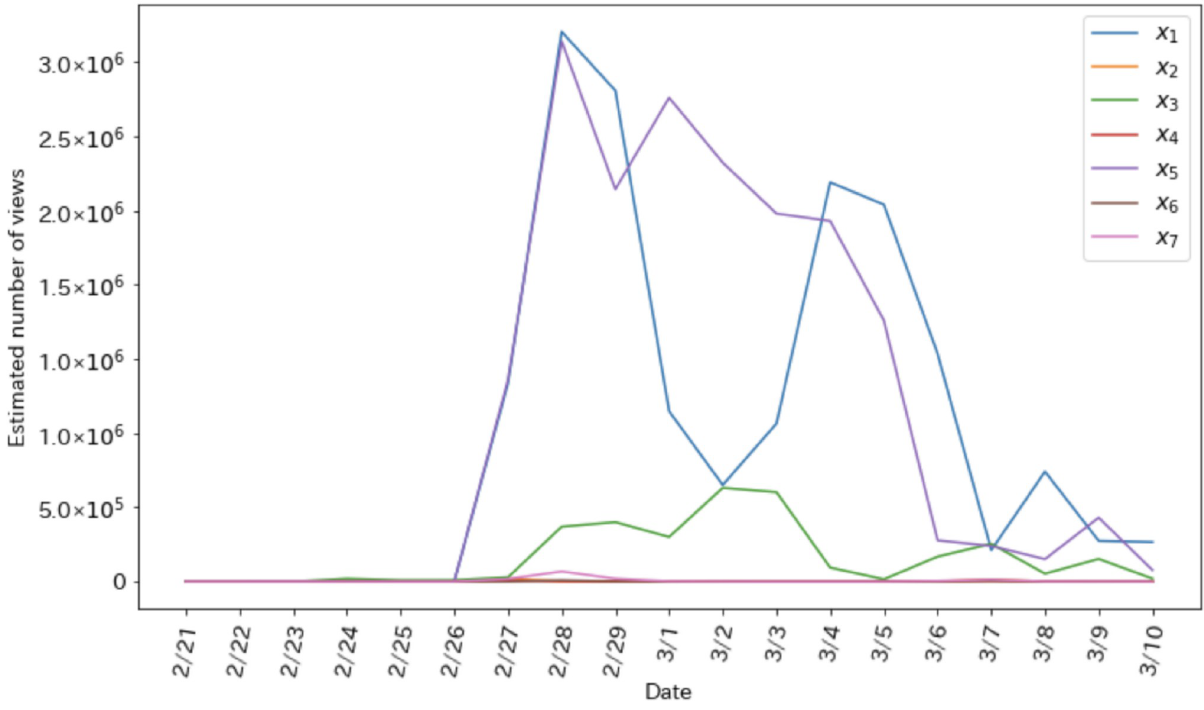
Fig 3. Estimated number of views of each